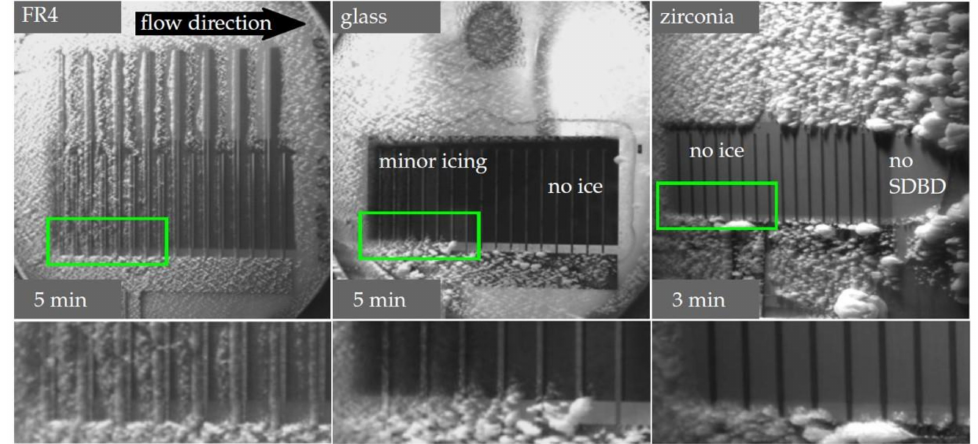
Figure 25. Anti-icing experiments of the three studied materials. Images below depict a magnification of the area marked in green (adapted from Lindner et al. [189] with permission under the Creative Commons Attribution